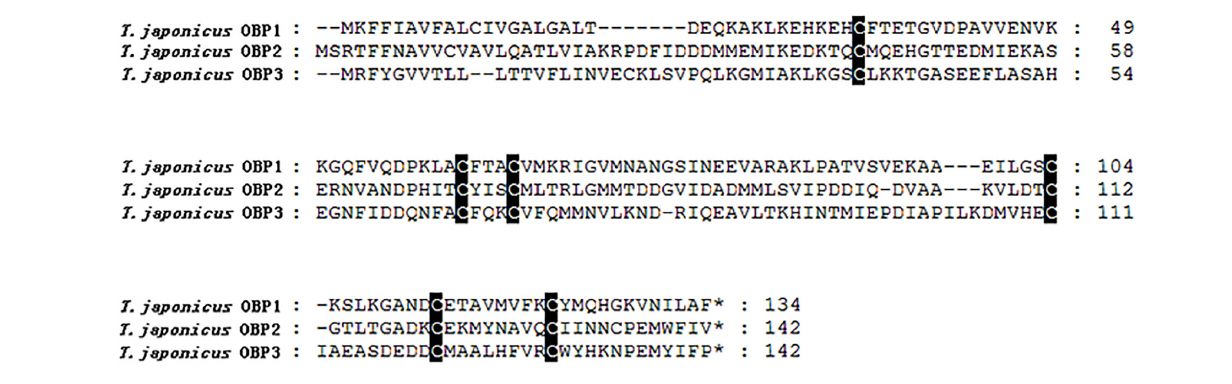
FIGURE 2 | Alignment of amino acid sequences of OBPs in Trissolcus japonicus